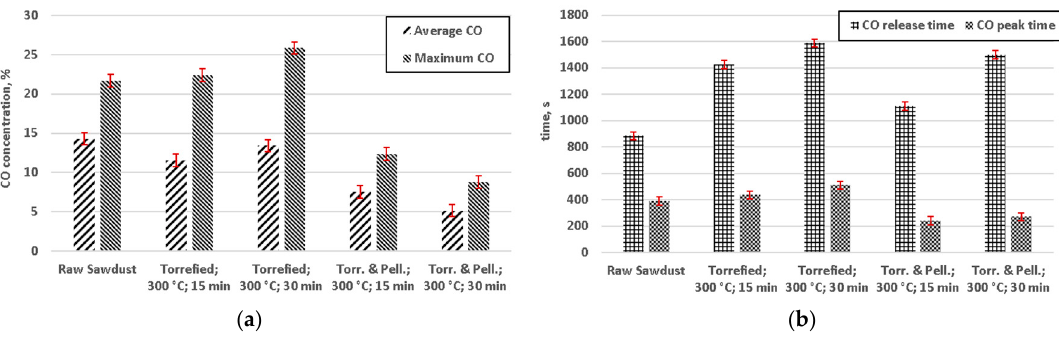
Figure 7. CO concentration for performed gasification experiments: ( a ) average concentrations of carbon monoxide; ( b ) release time and the time of peak concentration (Torr. & Pell.—torrefied and pelletized).